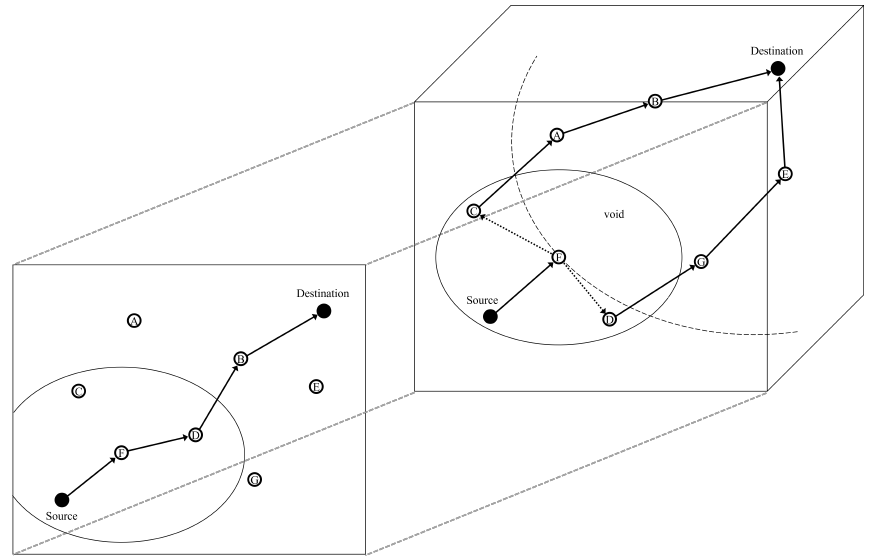
Figure 4. Void problem in 3D. As the dimension expands from 2D to 3D, internode connectivity weakens and the void problem appears more